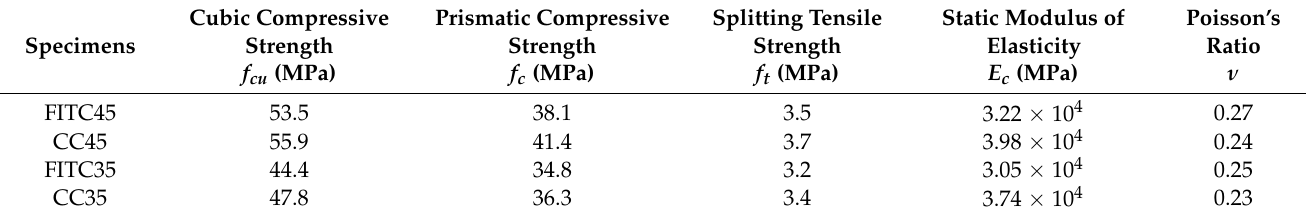
Table 6. Mechanical behaviour of